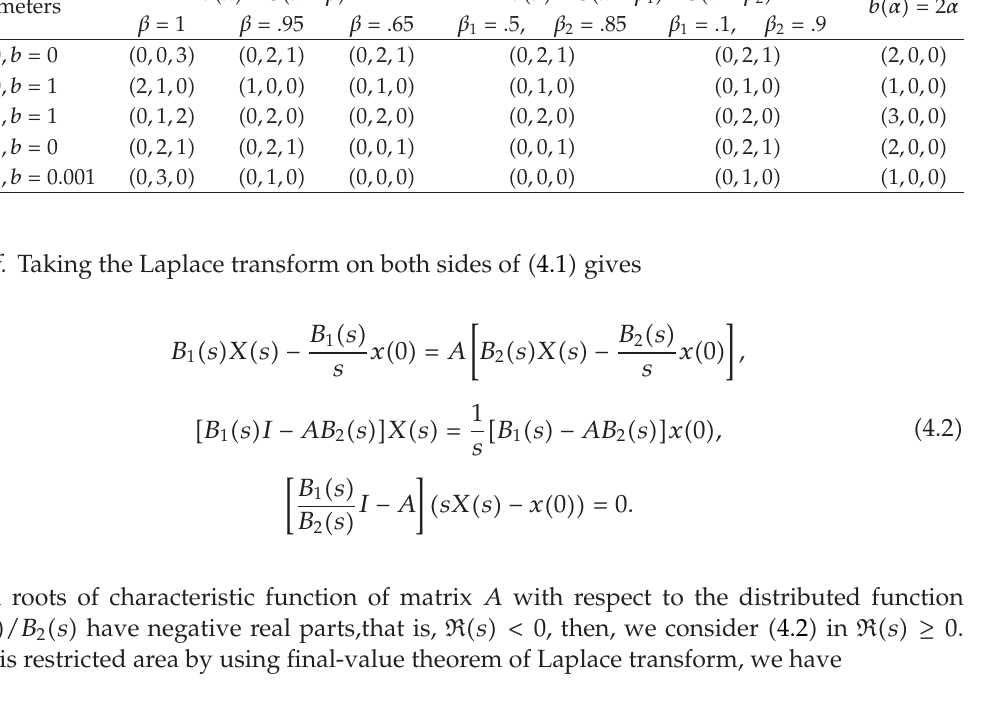
Table 1: Stability analysis of distributed order fractional WINDMI system.